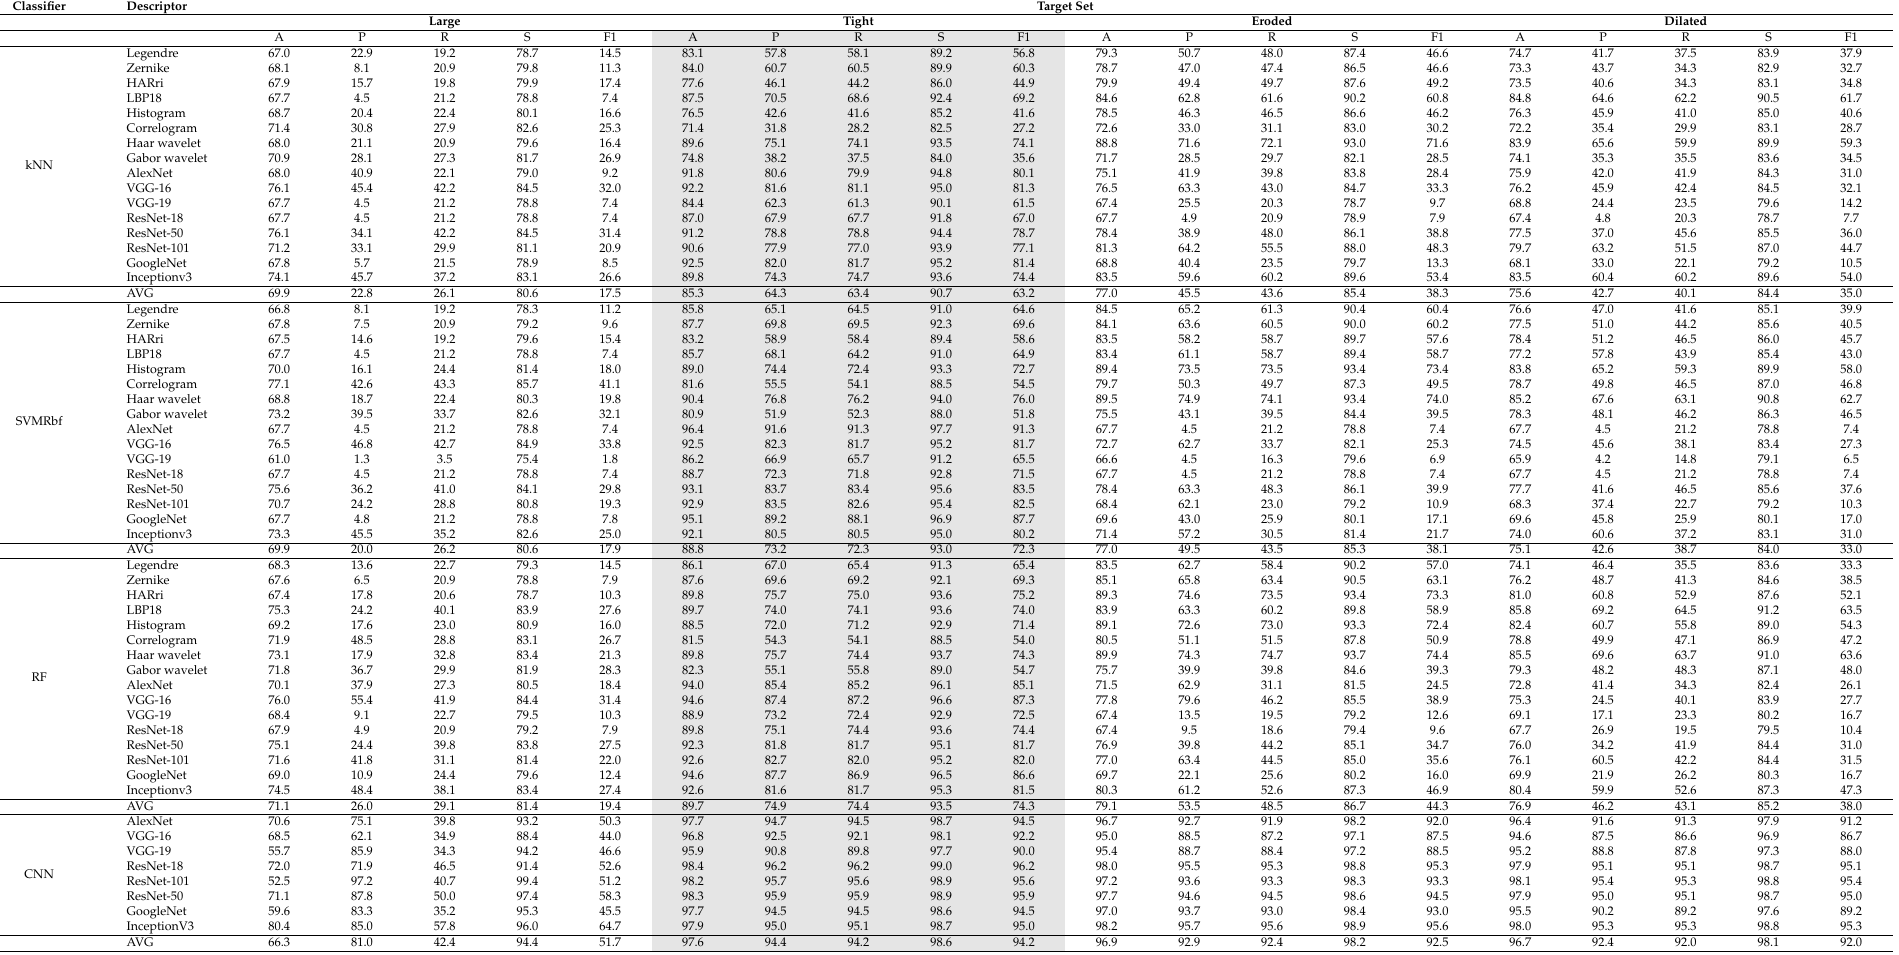
Table 5. R-WBC performance obtained with source models created exploiting the tight data set version and tested using in turn (from the left) the large, tight, eroded and dilated versions. Same-version performance are highlighted in